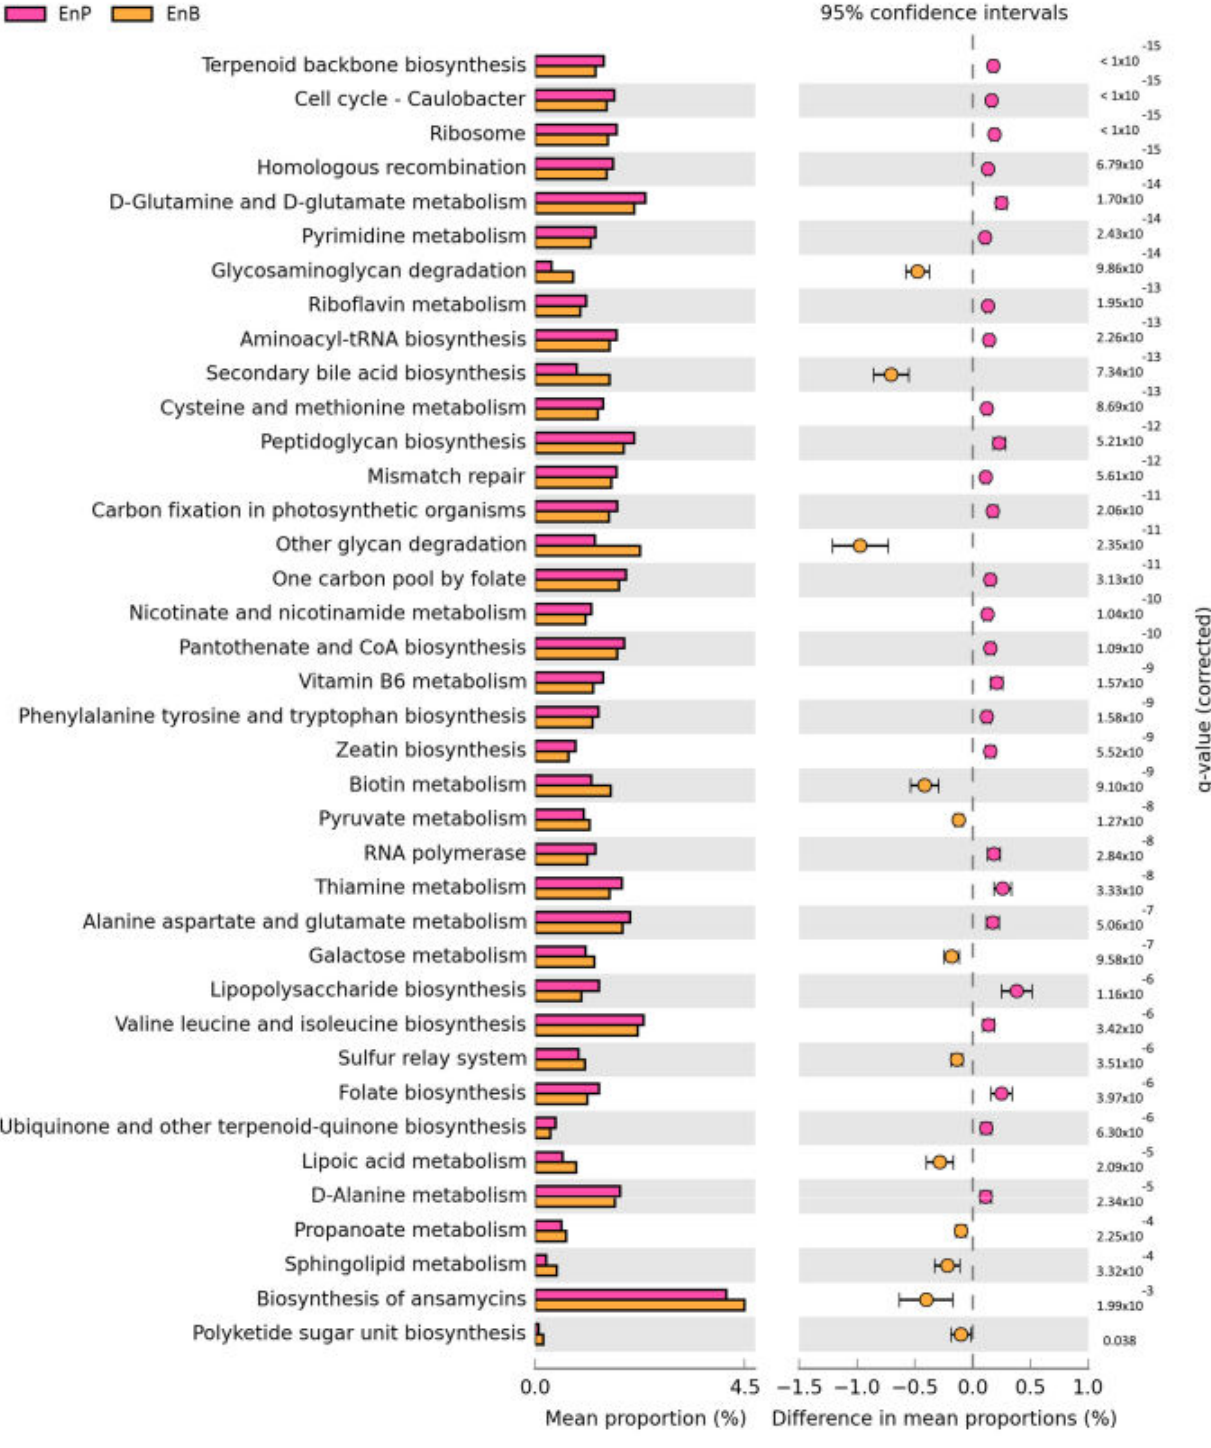
Figure 5. Enrichment analysis of microbial metabolic function. A comparison of predicted metabolic functions between enterotypes was performed by enrichment analysis. Bar plots display the mean proportion (%) of metabolic pathways for EnP and EnB. Differences in mean proportions were conducted using two-sided Welch’s t -test and multiple hypothesis correction by Benjamin’s test with the criteria of difference in mean proportion > 0.1% and q-value < 0.05. The enriched pathways in EnP and EnB were denoted by pink and orange dots,